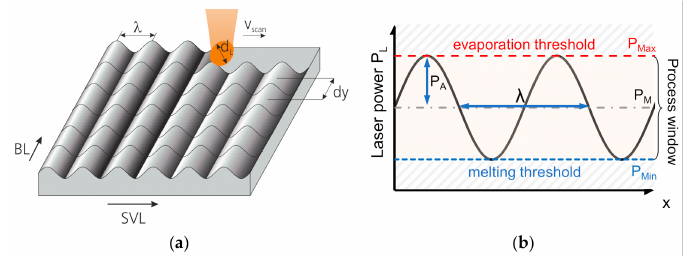
Figure 3. ( a ) Schematic for process strategy and crucial process parameters in WaveShape, and ( b ) schematic for sinusoidal modulation of laser power and process thresholds.